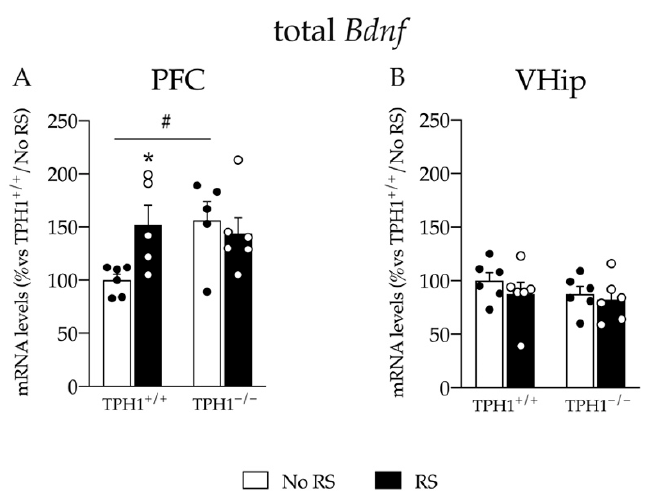
Figure 4. Analyses of total Bdnf mRNA levels in the PFC ( A ) and in the VHip ( B ) of TPH1 +/+ and TPH1 − / − male adult rats exposed to RS and sacrificed immediately after stress. The data, expressed as percentage of TPH1 +/+ /No RS (set at 100%), are the mean ± standard error of the mean (SEM) of at least 5 independent determinations. * p < 0.05 vs. naïve for the same genotype; # p < 0.05, vs. TPH1 +/+ for the same condition, two-way ANOVA with Fisher’s PLSD.